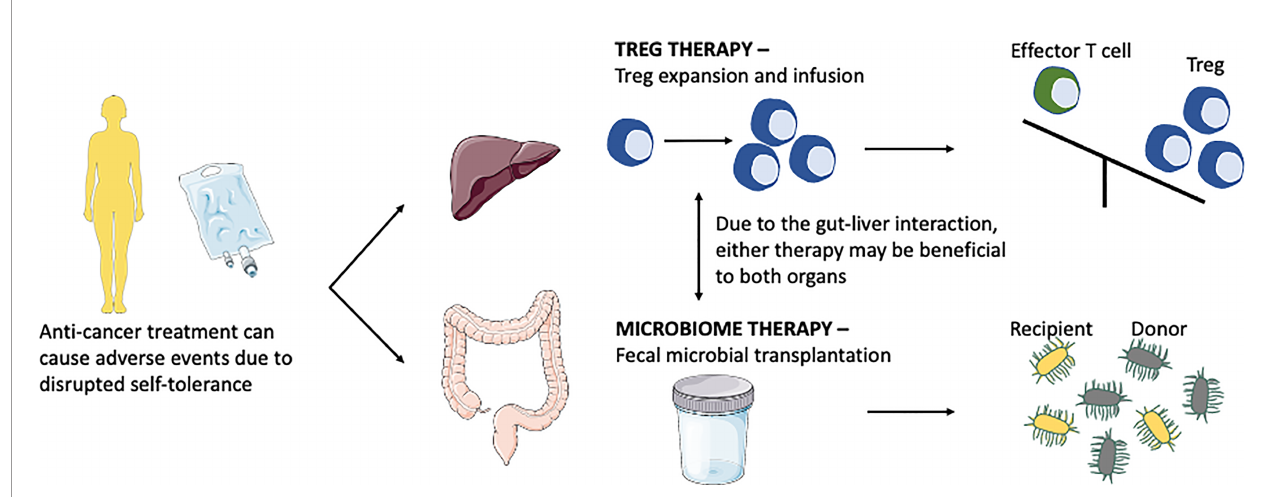
FIGURE 3 | Anti-cancer treatment disrupts self-tolerance leading to colitis and hepatitis, current research is focusing on microbiome therapy and Treg therapy to combat these diseases. Treg therapy aims to switch the balance from the effector cells arm to the Treg arm. Microbiome therapy via fecal microbial transplantation aims to modulate the microbiome by direct interaction or competition leading to host immunity